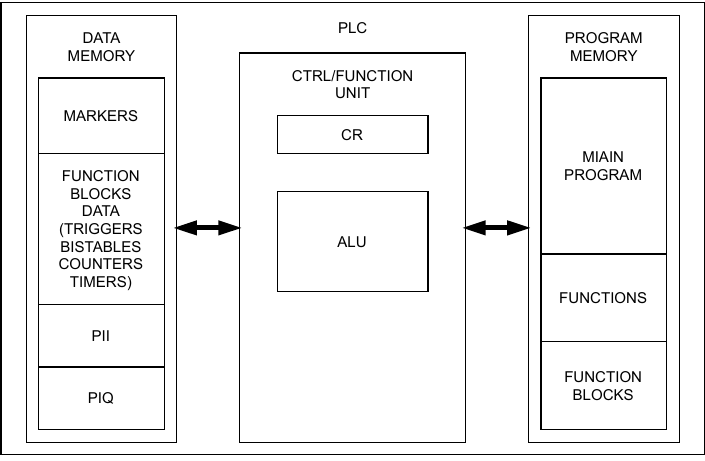
Figure 3. The architecture of the classical CPU of the